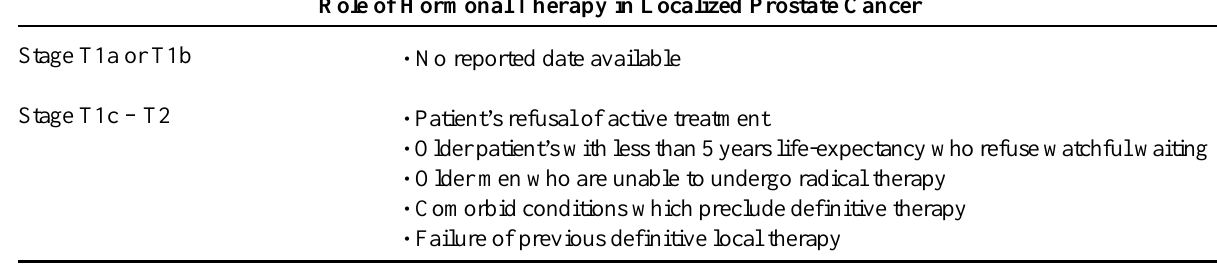
Table 1 – Role of hormone therapy in localized prostate cancer. Recommendation of the International Consultation on Prostate Cancer (ref.